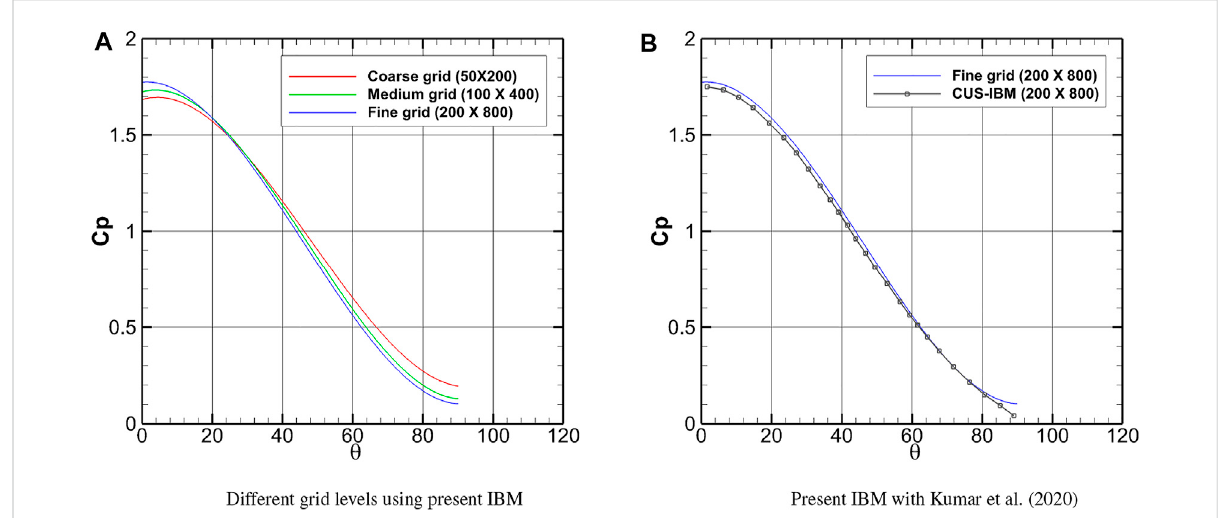
FIGURE 13 Comparisonofthepressurecoef fi cient;X-axisrepresentstheazimuthanglemeasuredclockwisefromtheleadingedge. (A) Differentgridlevels using present IBM. (B) Present IBM with Kumar et al.